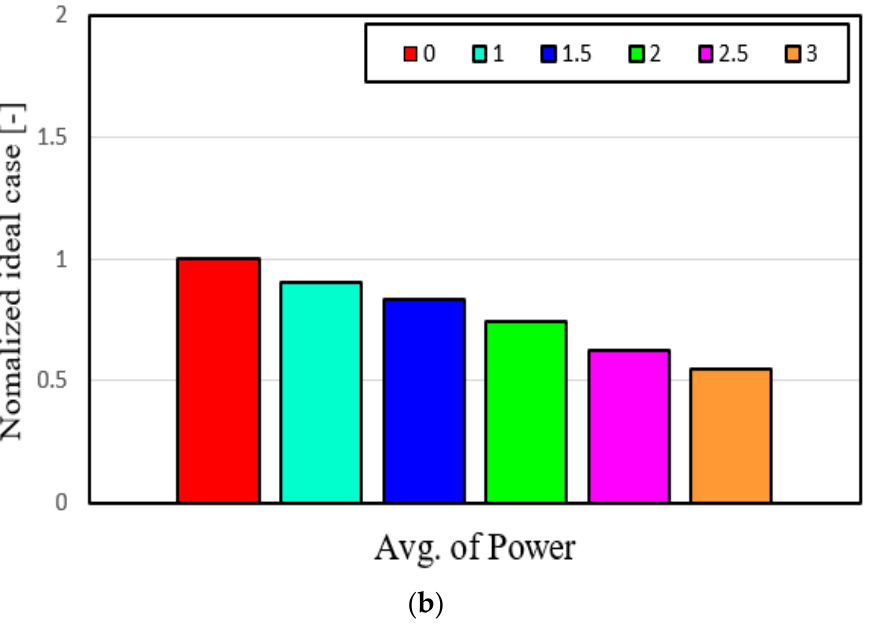
Figure 6. Characteristics according to delay time (s) of hydraulic actuator: ( a ) Standard deviation (std) of platform pitch motion of floating body; ( b ) average amount of power generated.